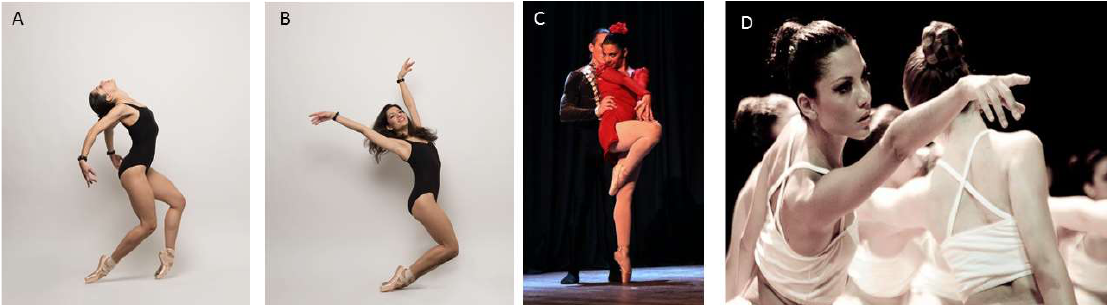
Figure 1. Coordination of complex patterns of behavior in multiple settings. ( A , B ) Maintaining and controlling difficult postures. ( C ) Building synchronous synergies in dyadic exchange. ( D ) Maintaining a harmonious flow in a crowd of dancers performing a choreography.